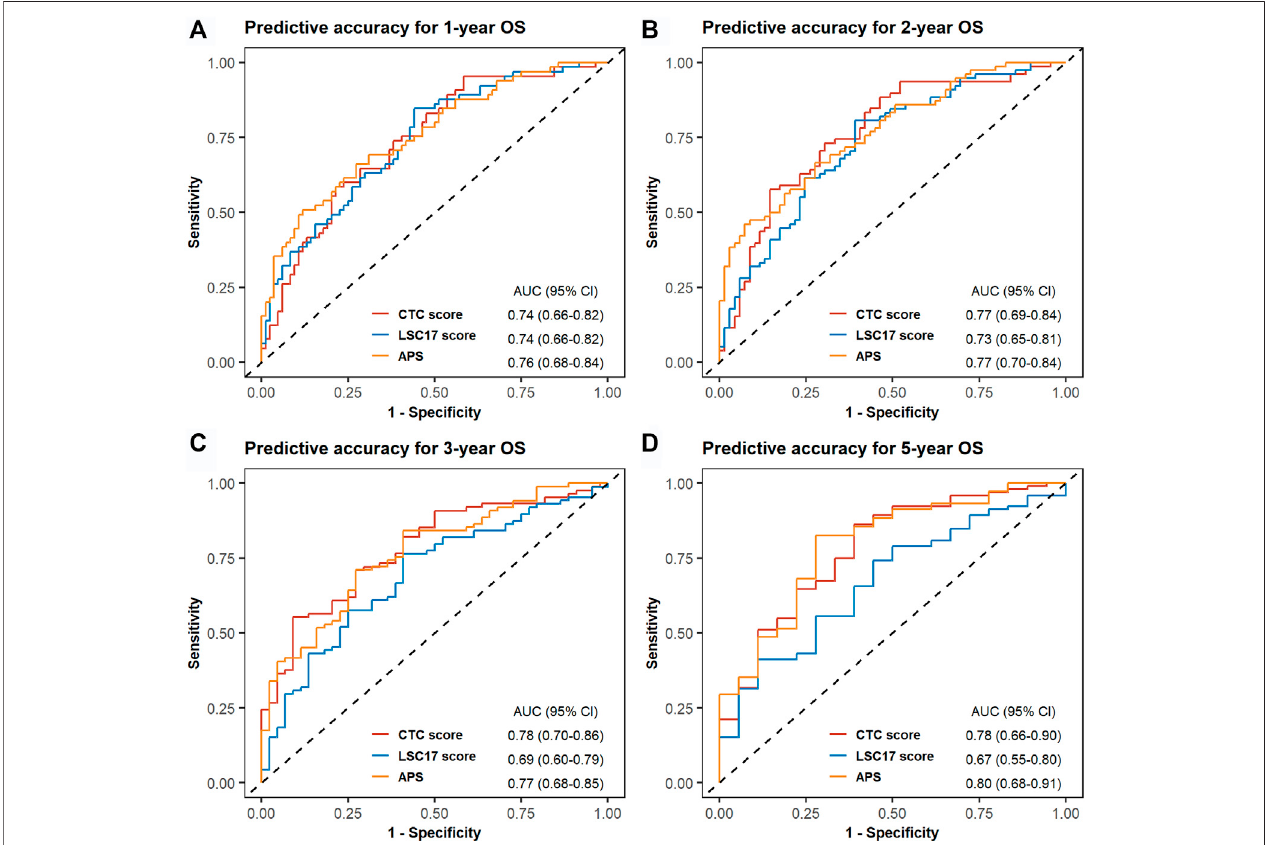
FIGURE4| Time-dependent receiver operating characteristic(ROC) curves for celltype compositionscore,LSC17score, and acute myeloid leukemia prognostic scoreofthevalidationsetTCGA-LAML.One-year (A) ,2-years (B) ,3-years (C) ,and5-years (D) ROCcurvesandthecorrespondingareasunderROCcurvewith95%CI are displayed.